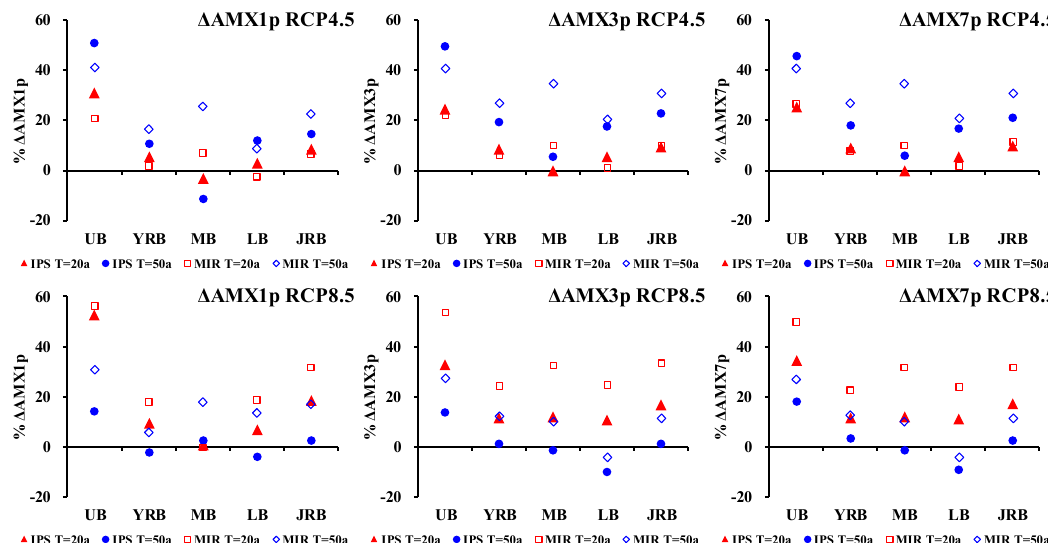
Figure 6. The projected changes to average AMX n p- T yr ( n = 1, 3, 7; T = 20a, 50a) of Upper basin (UB), Yalong River Basin (YRB), Middle basin (MB), Lower basin (LB) and the whole Jinsha River Basin (JRB) with respect to the reference period (1961 to 1990) derived from the projections of RCP4.5 and RCP 8.5 climate scenarios of IPSL-CM5A-LR and MIROC-ESM-CHEM.